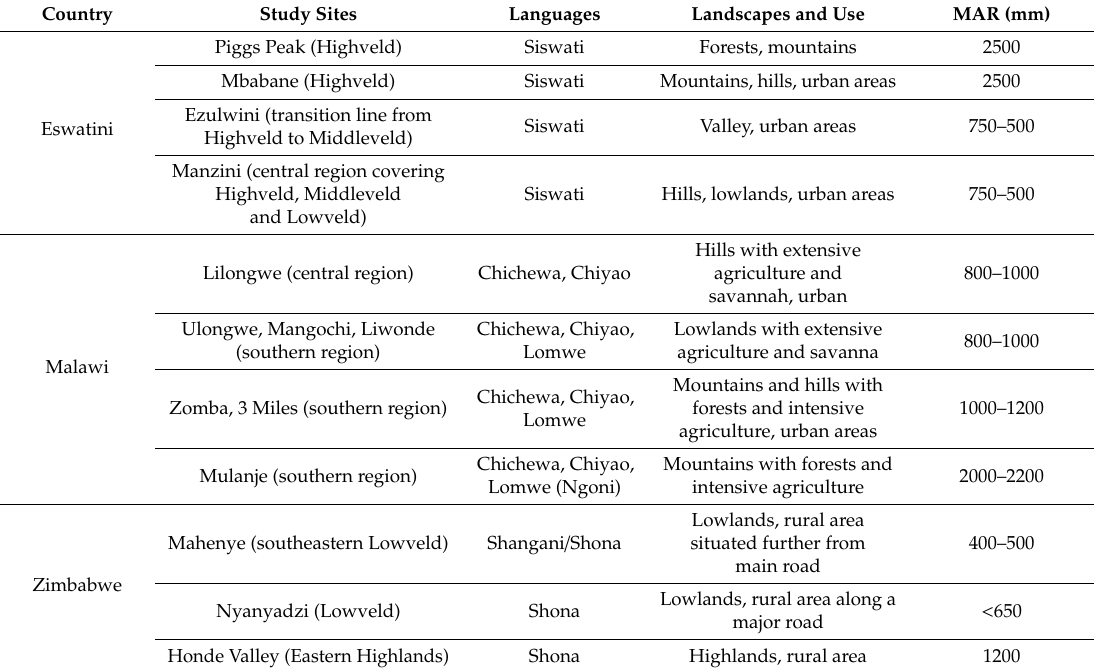
Table 1. Selection attributes of the di ff erent study